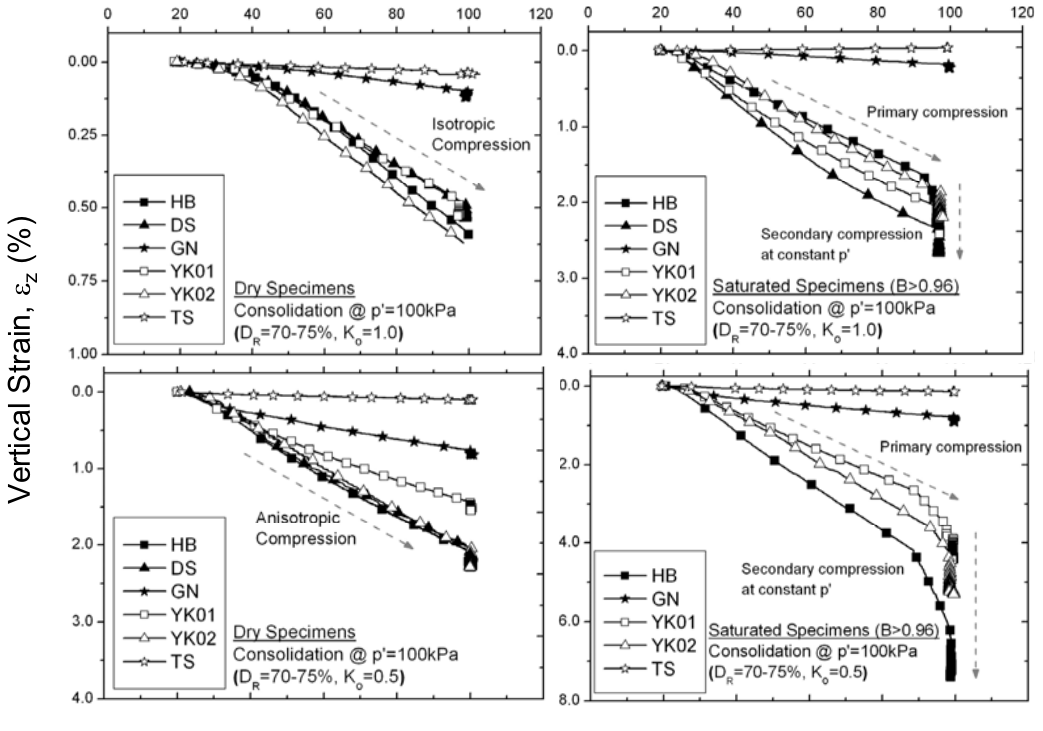
Fig. 9. Typical dry and saturated consolidation response of all materials at p 0 =100kPa.